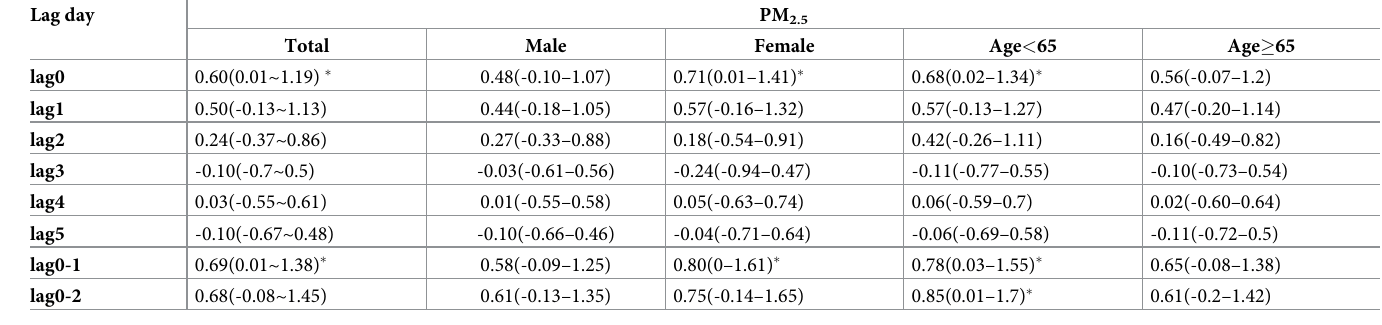
Table 4. The percent change of daily stroke morbidity in every 10 μ g/m 3 increase of PM 2.5 to different genders and age groups under different lag of days. Lag